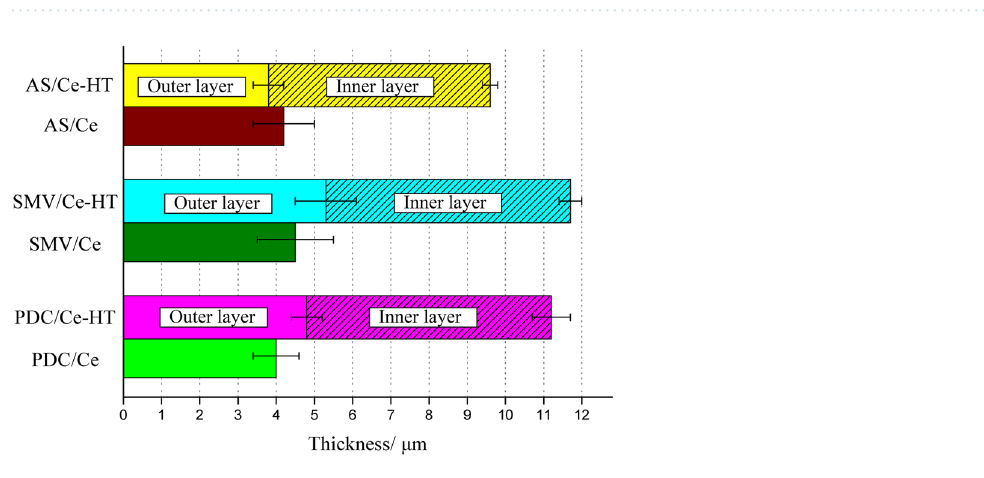
Figure 12. Evolution of total coating